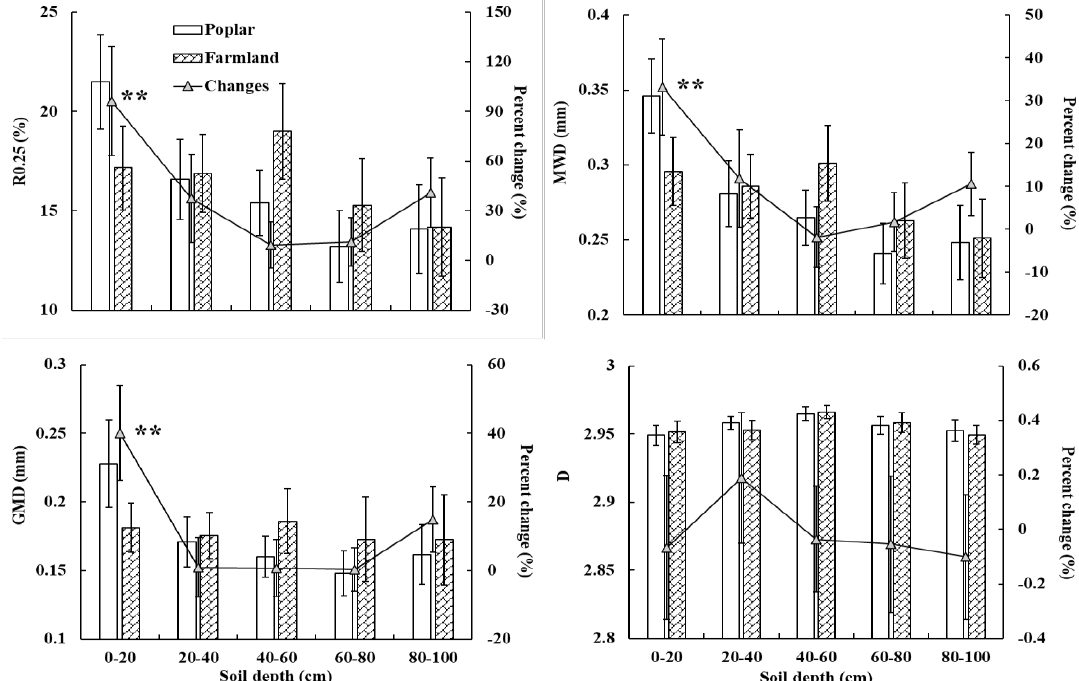
Figure 3. The effects of shelterbelt on R 0.25 , MWD, GMD and D of soil aggregates in 0 – 20 cm, 20 – 40 cm, 40 – 60 cm, 60 – 80 cm and 80 – 100 cm. Broken lines are percent changes in shelterbelt − induced R 0.25 , MWD, GMD and D of soil aggregate, ** indicates significant differences at p < 0.001 between the changes in shelterbelt − induced and farmlands in same soil layer. Error bars are the standard errors.